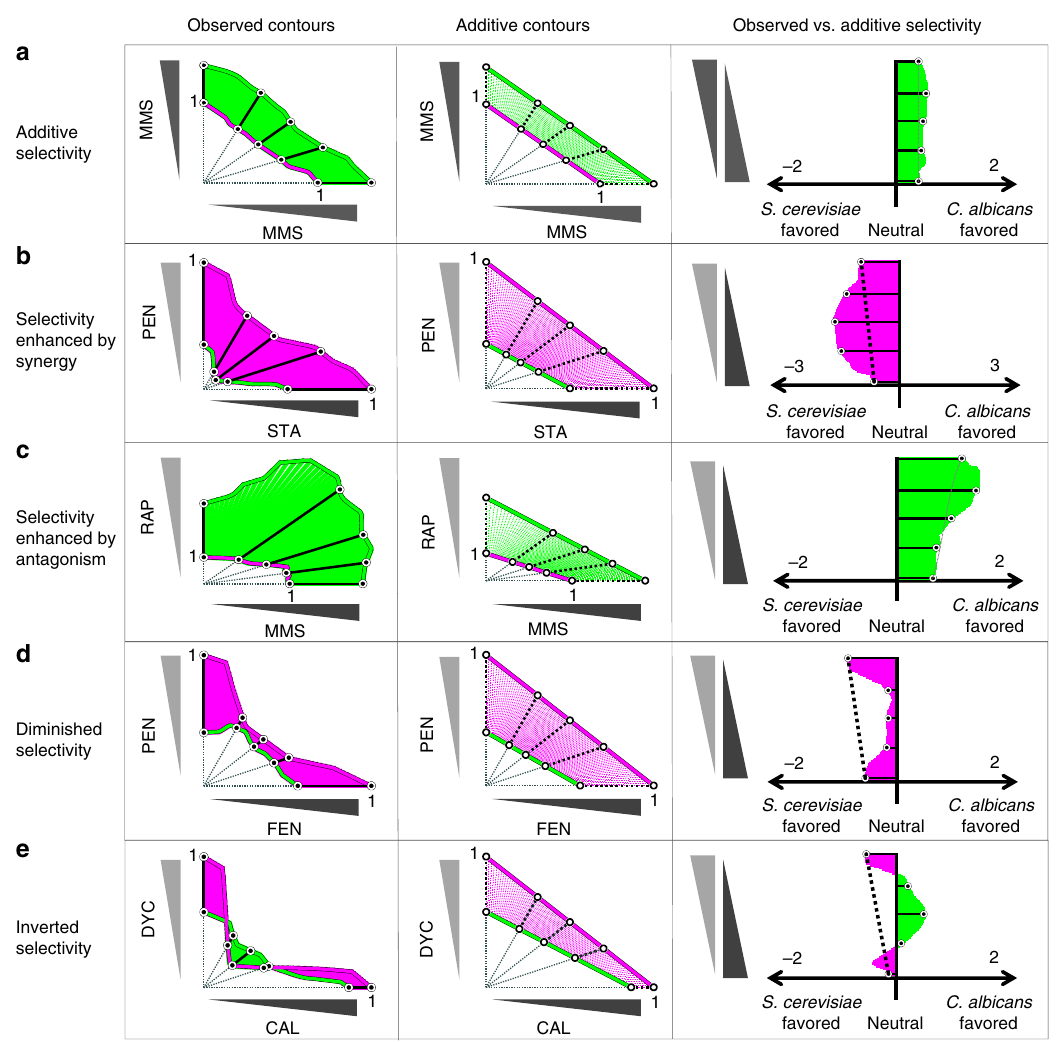
Fig. 3 Drug interactions may enhance, diminish or invert selectivity. Left panel: Observed isophenotypic contours of drug-interaction assays for S. cerevisiae (magenta) and C. albicans (green) are overlaid in a 2D grid adjusted for relative concentration. We linearly transformed the isophenotypic contours for drug-interaction assays so that S. cerevisiae ’ s isophenotypic contour intercepted both x and y axes at 1. Selectivity of a combination was determined by the log ratio of the distance from the origin to the C. albicans vs. S. cerevisiae contours (log 2 ( d albicans / d cerevisiae )). Selectivity is therefore positive for drugs or combinations that select for C. albicans . Middle panel: the middle panel demonstrates the null model for expected combination selectivity, assuming drug pairs are additive. As in observed selectivity, expected selectivity is calculated based on the log ratio of distances from the origin with positive expected selectivity corresponding to an expected selectivity for C. albicans , in the absence of synergistic or antagonistic drug interactions. Right panel: observed (solid) and expected selectivity (dashed line) scores are overlaid. Green- or magenta- shaded regions represent observed C. albicans or S. cerevisiae selectivity. Deviations from expected selectivity indicates a change in selectivity due to drug interactions. Five representative drug pairs are shown with expected (additive) selectivity ( a MMS + MMS), enhanced selectivity ( b pentamidine and staurosporine and c MMS and rapamycin), diminished selectivity ( d fenpropimorph and pentamidine), and inverted selectivity ( e calyculin A and dyclonine), compared to single-agent expected